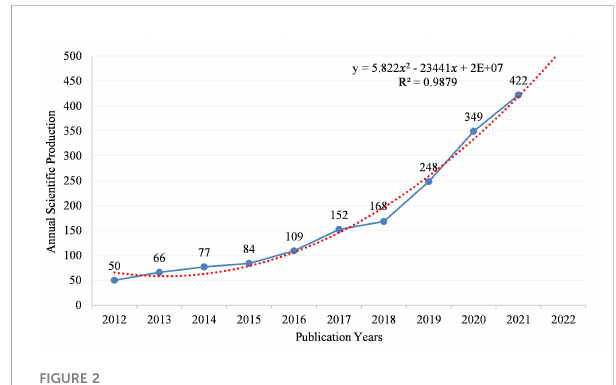
FIGURE 2 Annual scienti fi c output and the polynomial fi tting curve of output in